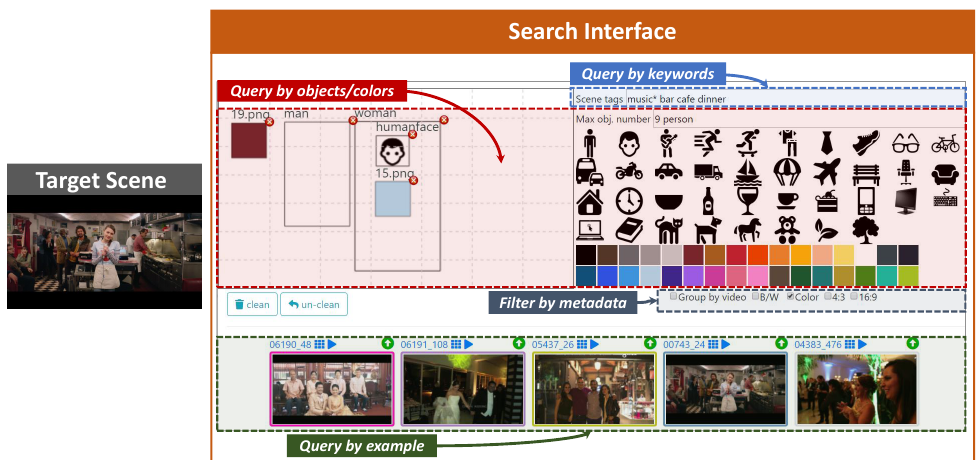
Figure 3. An example of how to use the VISIONE Search Interface to find the target scene: search for images that contain a woman in light blue t-shirt in the foreground and a man to her right (query by object/colors), images labeled with “music, bar, cafe, dinner” (query by keywords), or images similar to some others (query by